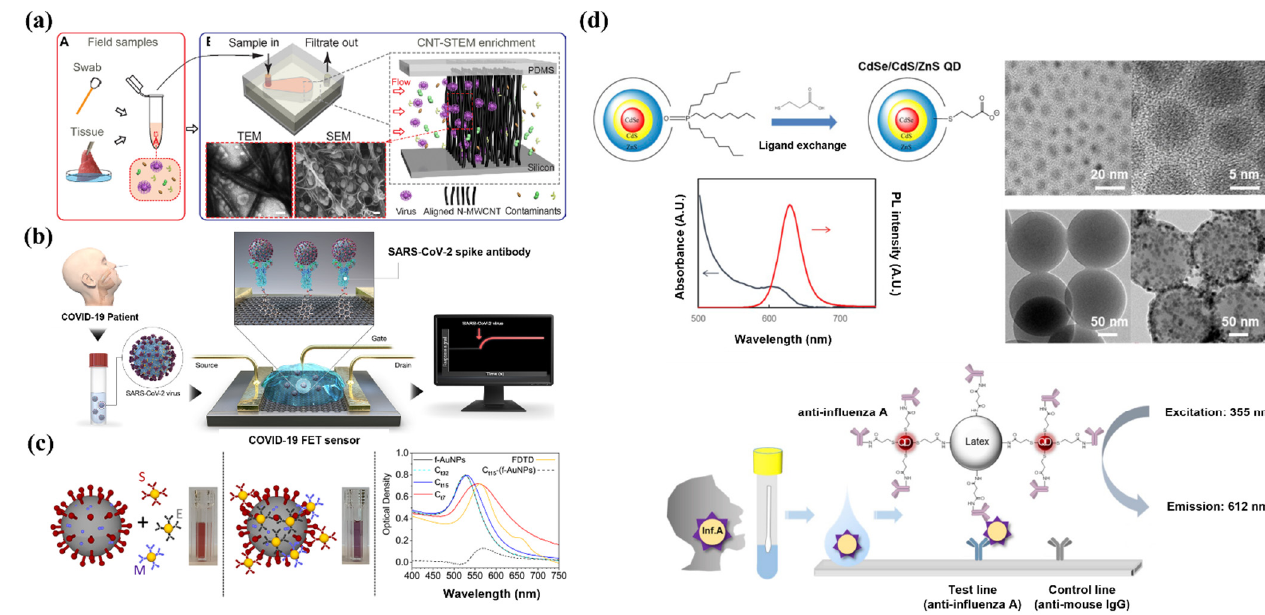
Figure 1. Application of nanomaterials for diagnosis with advanced sensitivity and selectivity. ( a ) Schematic of using carbon nanotubes for H5N2 isolation and concentration, directly from in situ samples. Transmission electron microscopy (TEM) and scanning electron microscopy (SEM) images of H5N2 separated by carbon nanotubes are shown. Reproduced with permission from [30]. Copyright (2016) American Association for Advancement of Science. ( b ) Schematic representation of graphene as a sensing material for detecting SARS-CoV-2. The SARS-CoV-2 spike antibody binds to graphene and the reaction with the target is converted into an electrochemical signal. Reproduced with permission from [31]. Copyright (2020) American Chemical Society. ( c ) AuNP-based colorimetric diagnosis of coronavirus disease (COVID-19). The surface-modified AuNPs with antibodies bind to the virus, which shifts the absorption wavelength of AuNPs. The shift in absorption wavelength changes the color of AuNPs from red to purple. Reproduced with permission from [32]. Copyright (2020) American Chemical Society. ( d ) Synthesis schematic of CdSe/CdS/ZnS quantum dots (QDs) and mechanism of application in rapid diagnostic strips. TEM images and fluorescence spectrum of synthesized QDs. Influenza A virus was detected using the fluorescence emission spectrum of the QDs on the rapid diagnostic strip. Reproduced with permission from [33]. Copyright (2020) Elsevier.